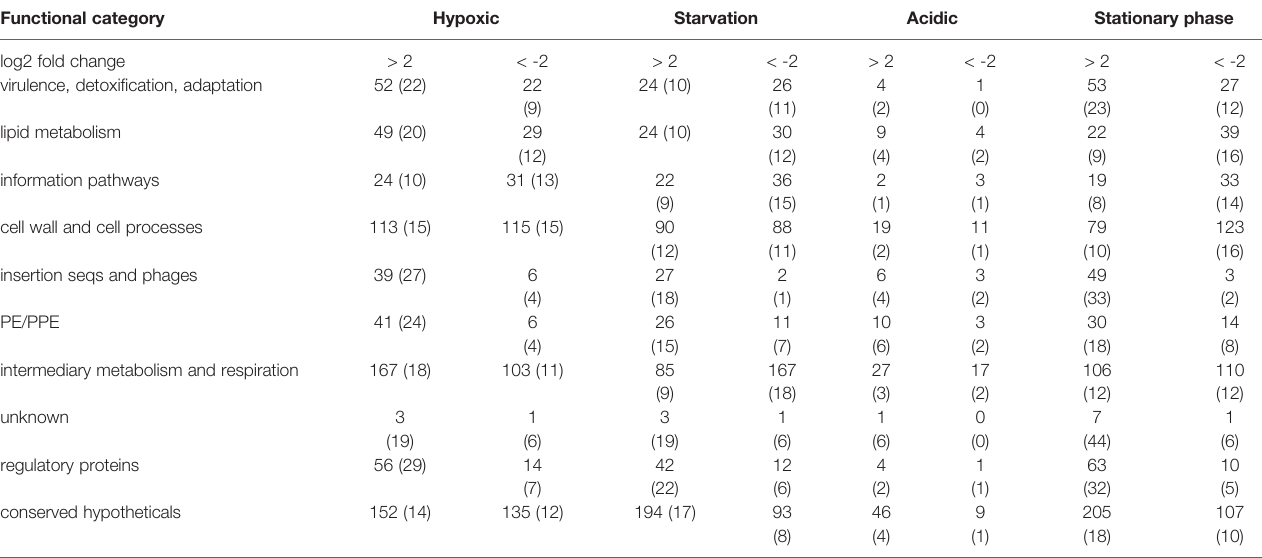
TABLE 1 | Classi fi cation of the genes induced or repressed in M. tuberculosis grown under hypoxic, nutrient starvation, acidic or stationary phase condition compared to exponential growth condition. Functional category Hypoxic